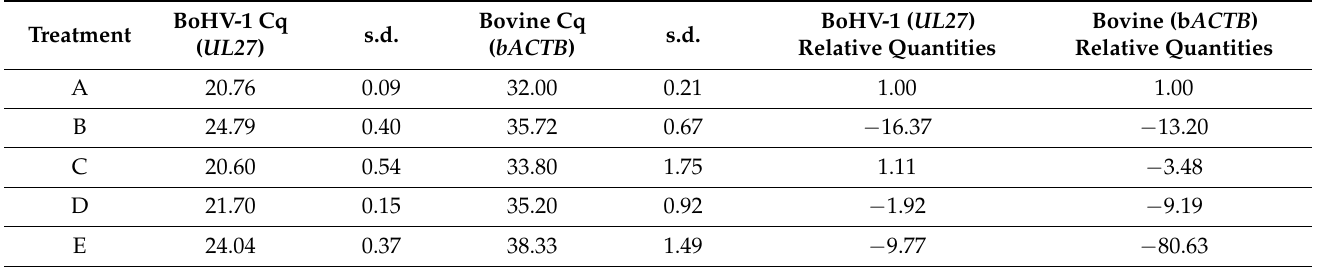
Table 1. Effect of different non-viral nucleic acid depletion treatments on recovery of BoHV-1 and bovine genomic DNA from in vitro bFLC